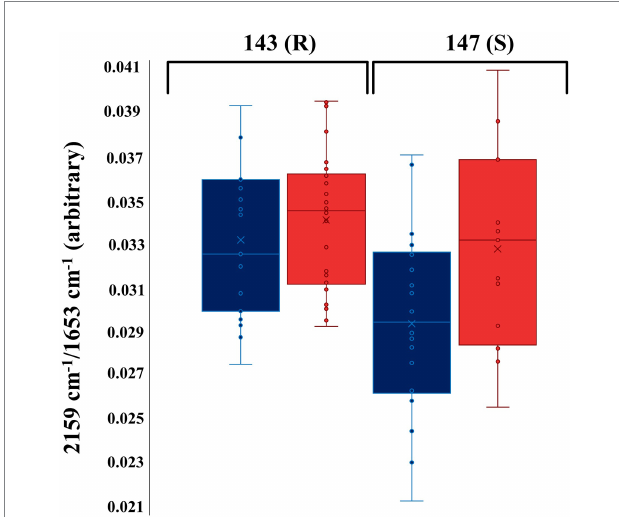
FIGURE 4 Box whisker plot of O-PTIR spectral data indicating the peak intensity ratio of the selected C–D stretching vibration (2,159 cm − 1 ) to amide I (1,654 cm − 1 ) at the 4 h timepoint. Blue and red box colors represent TMP-treated (T) and untreated (U) groups of bacterial cells, respectively. The numbers in the figure represent the UPEC isolates. (R) and (S) characterize the resistant and susceptible strains, respectively.